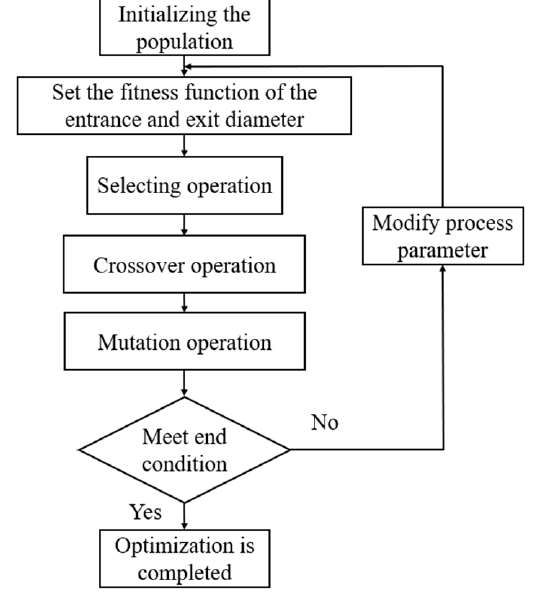
Figure 5. Femtosecond laser process parameters optimization flow chart with genetic algorithm. The Taguchi method is a low-cost and highly effective quality engineering